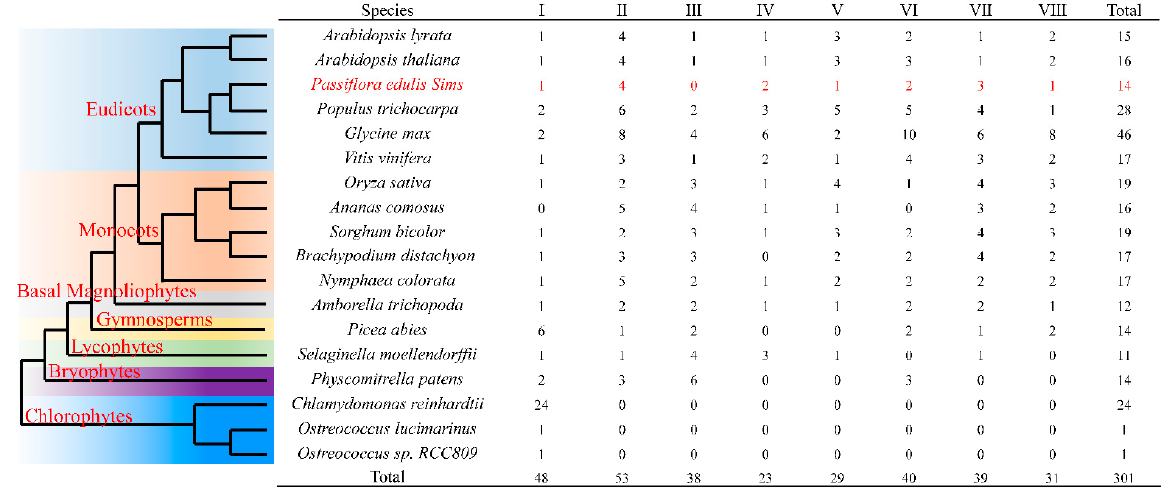
Figure 3. Phylogenetic tree of SBP family proteins among passion fruit, rice, Arabidopsis , grape, and sorghum. Pe, Passiflora edulis Sims; Os, Oryza sativa ; AT, Arabidopsis thaliana ; Vv, Vitis vinifera ; and Sb, Sorghum bicolor . 2.3. Gene Structure and Conserved Motif Analysis of SBP Genes in Passion Fruit